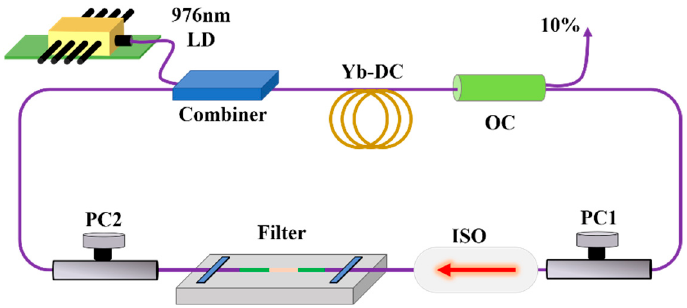
Figure 2. Experimental schematic diagram of the all-fiber mode-locked laser.